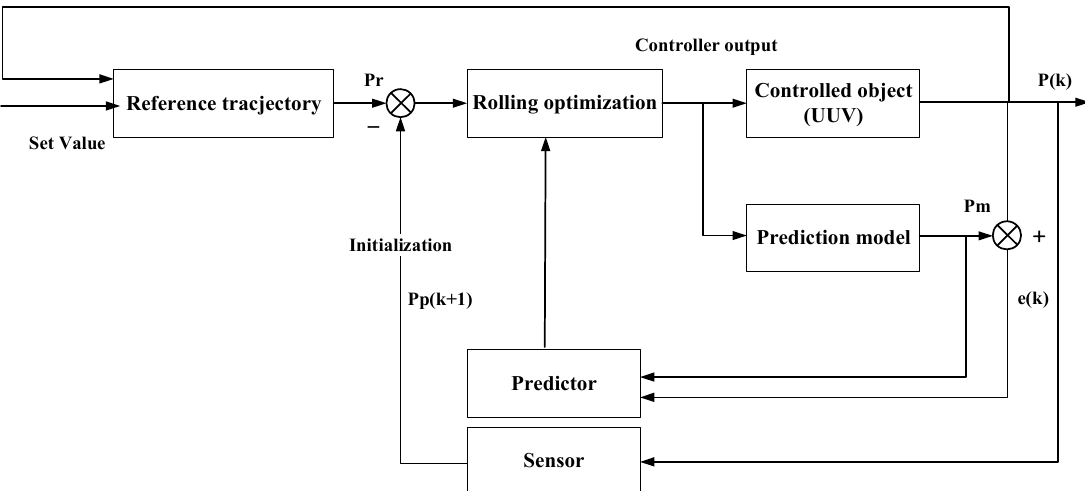
Figure 3. Nonlinear model predictive controller framework.